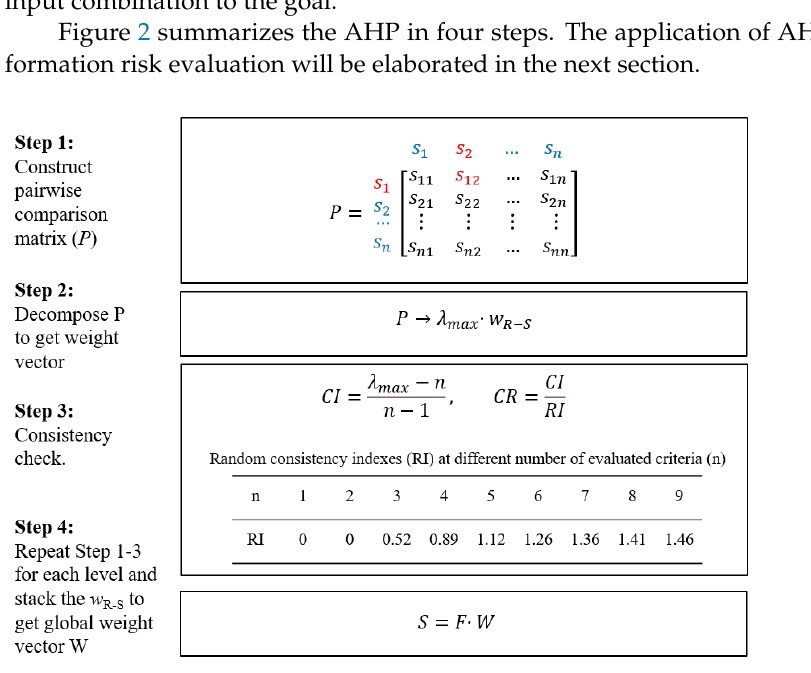
Table 3. Comparison matrix and weight for secondary level.